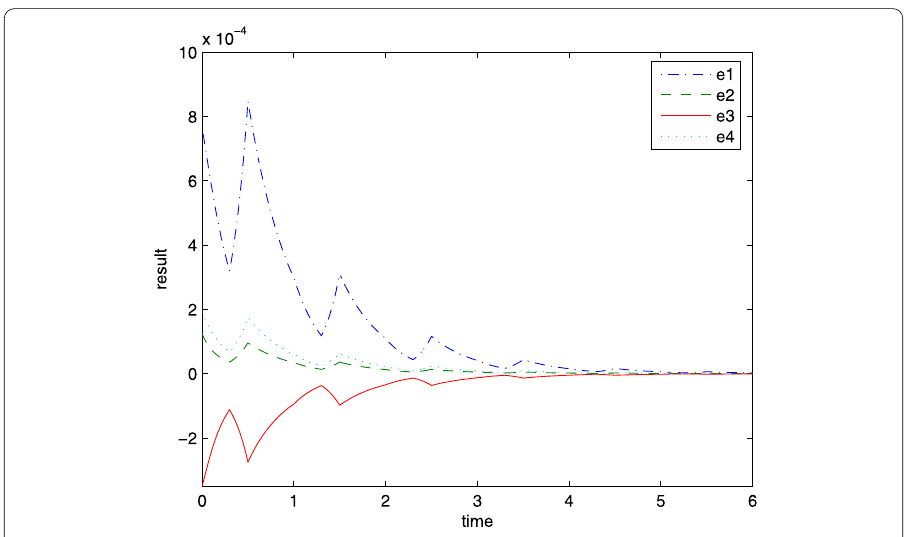
Figure 3 Sandwich synchronization between two memristor-based hyperchaotic systems with τ =